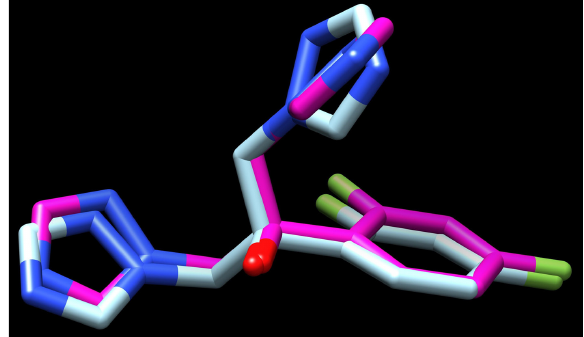
FIGURE 1 - The co-crystallized fluconazol FCZ (from 1EA1. pdb, colored cyan) overlaid onto the redocked fluconazol (colored magenta).